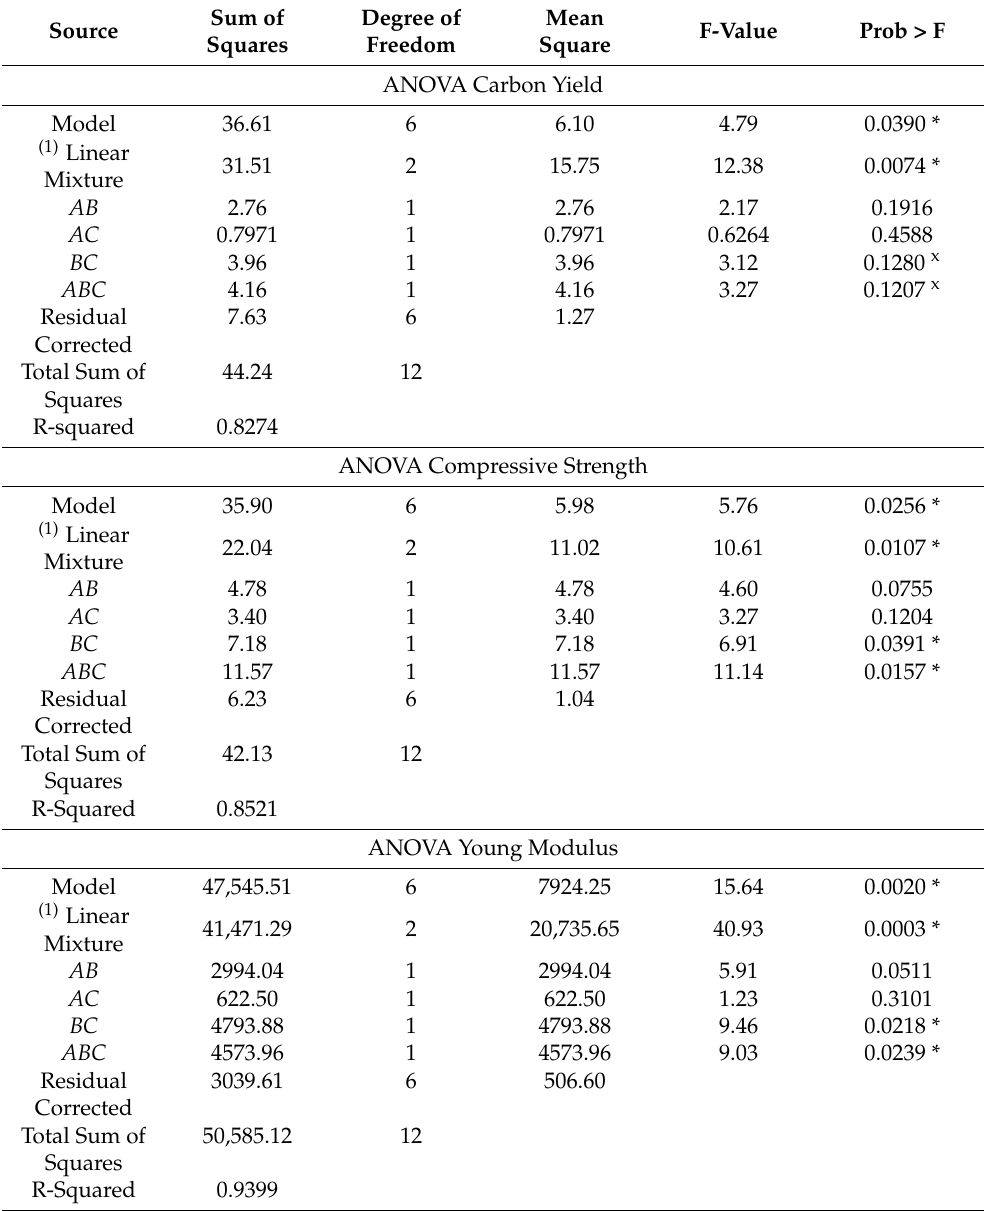
Table 4. ANOVA results for Equations